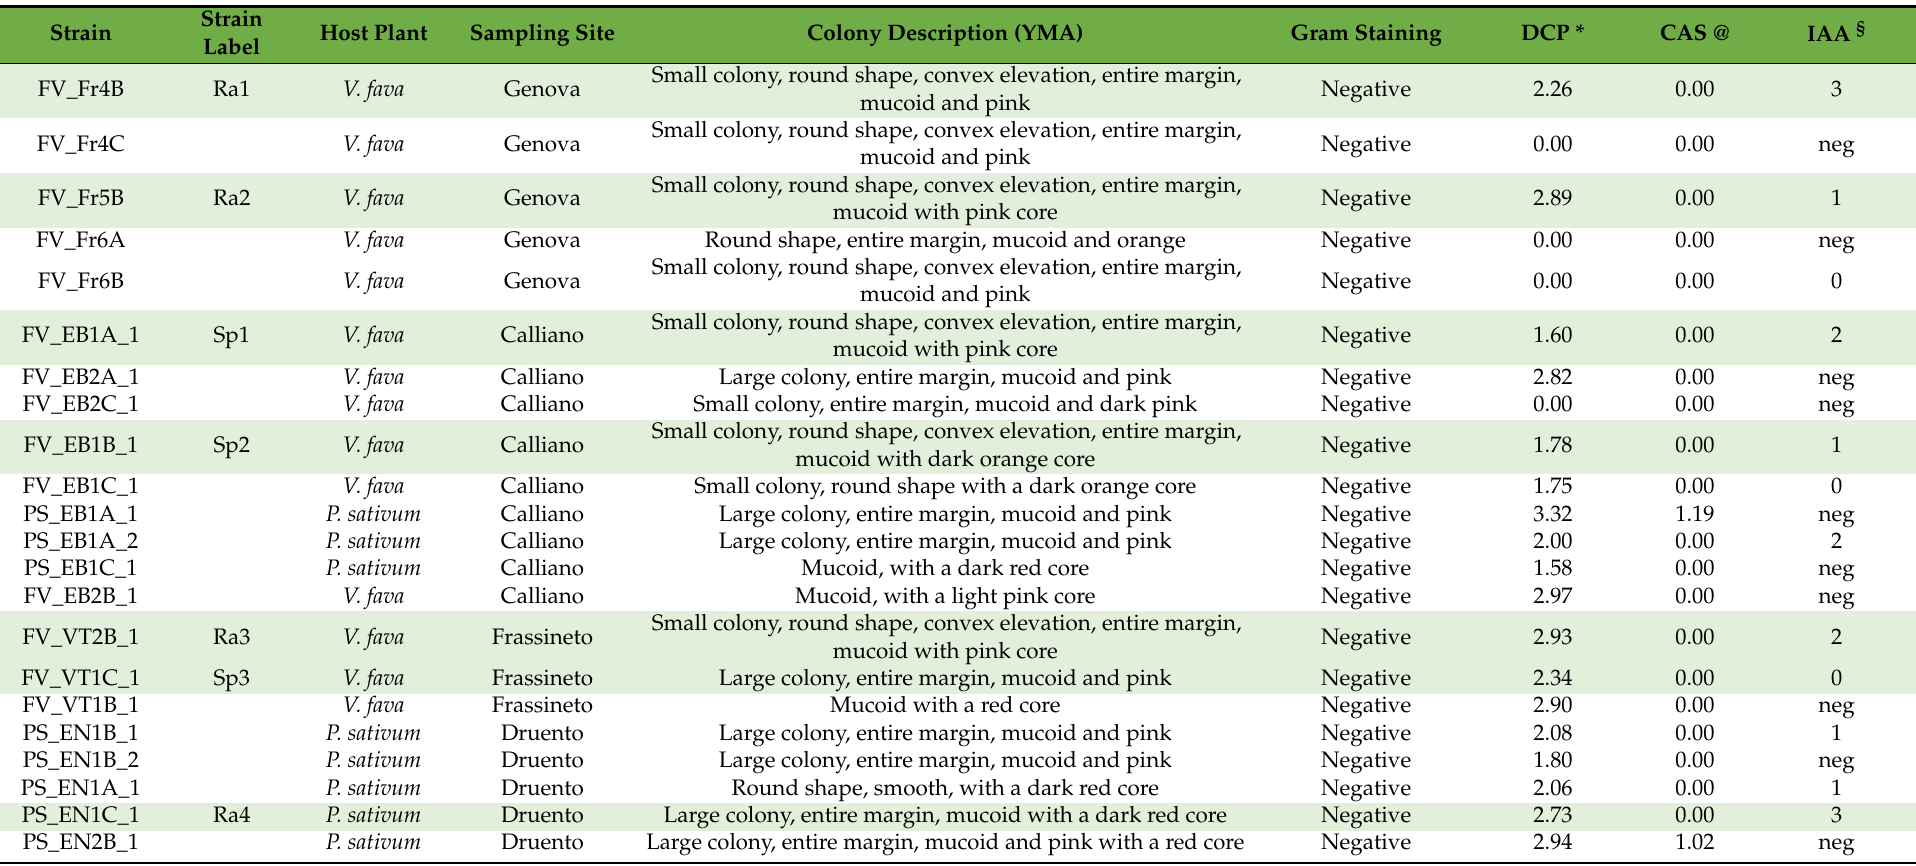
Table 1. Characterization of different strains isolated from compared to untreated cells (green) Vicia fava and Pisum sativum nodules.